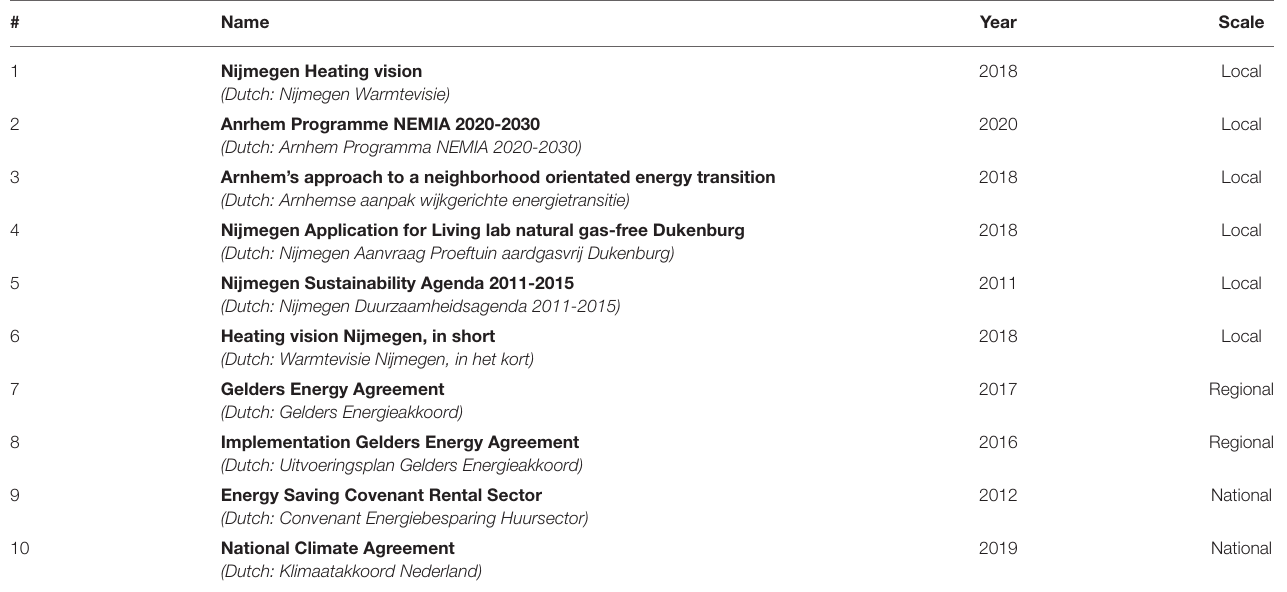
TABLE 1 | Policy documents